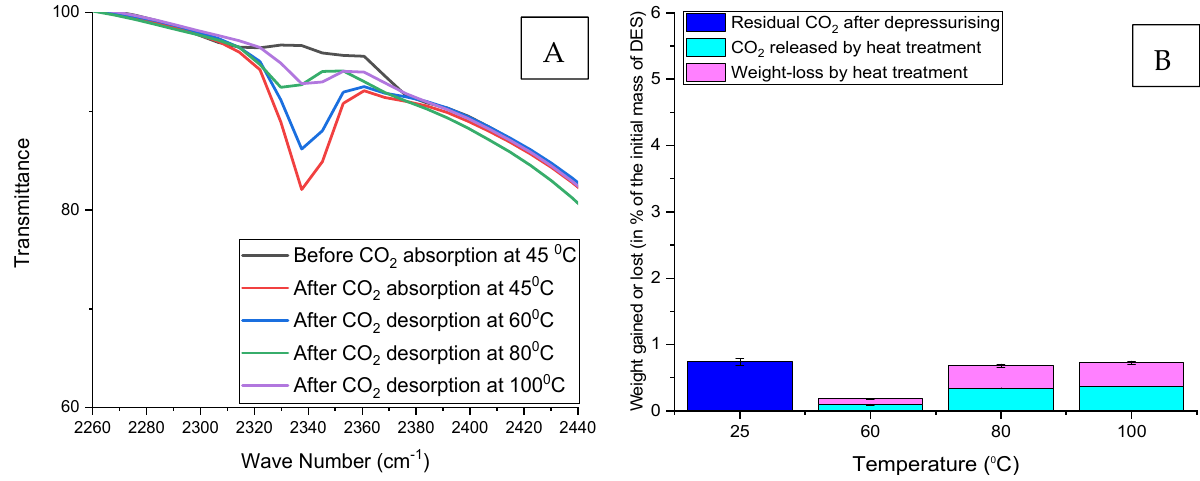
Figure 13. Regeneration of ChCl:LvAc (1:3:0) after CO 2 absorption at 45 °C. ( A ) Reduction in FTIR transmittance peak associated with the double carbonyl group with increasing regeneration temperature; ( B ) residual CO 2 after depressurisation, CO 2 released by heat treatment and weight loss after regeneration at different temperatures.